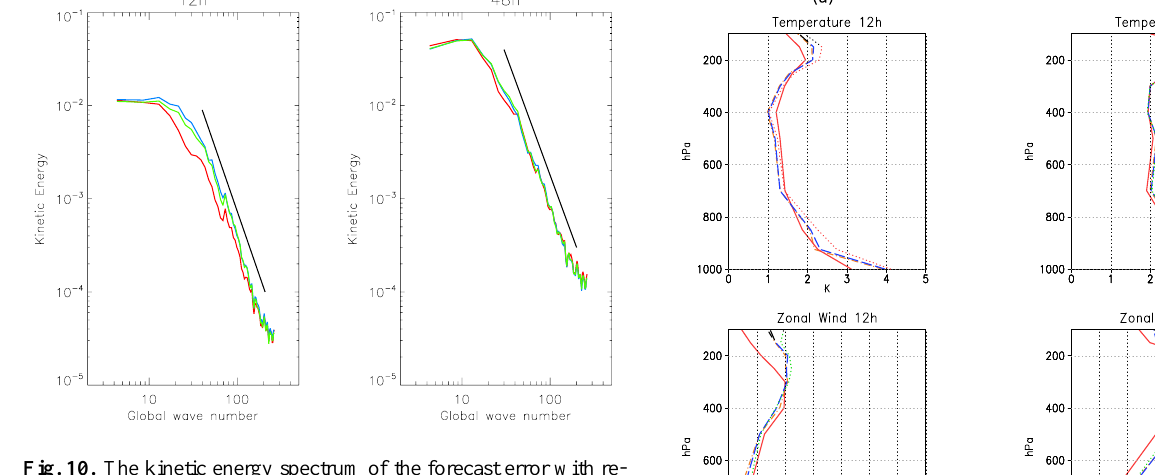
Fig. 10. The kinetic energy spectrum of the forecast error with re- spect to the global wave number at 12-h and 48-h forecast lead times in a log-log scale. Shown is the error for Strategy 1 (blue), Strategy 2 (green) and Strategy 3 (red). The straight solid line with slope − 3 indicates the scaling law for the kinetic energy in the inertial range for two-dimensional turbulence.